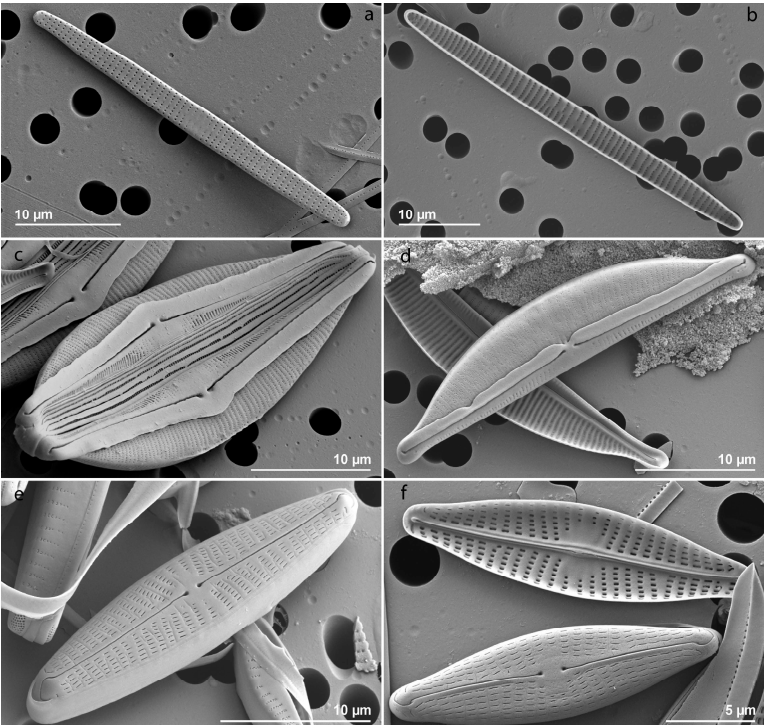
Figure 8. Scanning Electron Microscopy illustrations of some individuals observed in the studied springs. Fragilaria famelica ( a , b ). Halamphora coffeaeformis ( c , d ). Navicula sanctamargaritae ( e ). Navicula veneta ( f ). Diversity 2023 , 15 , x FOR PEER REVIEW